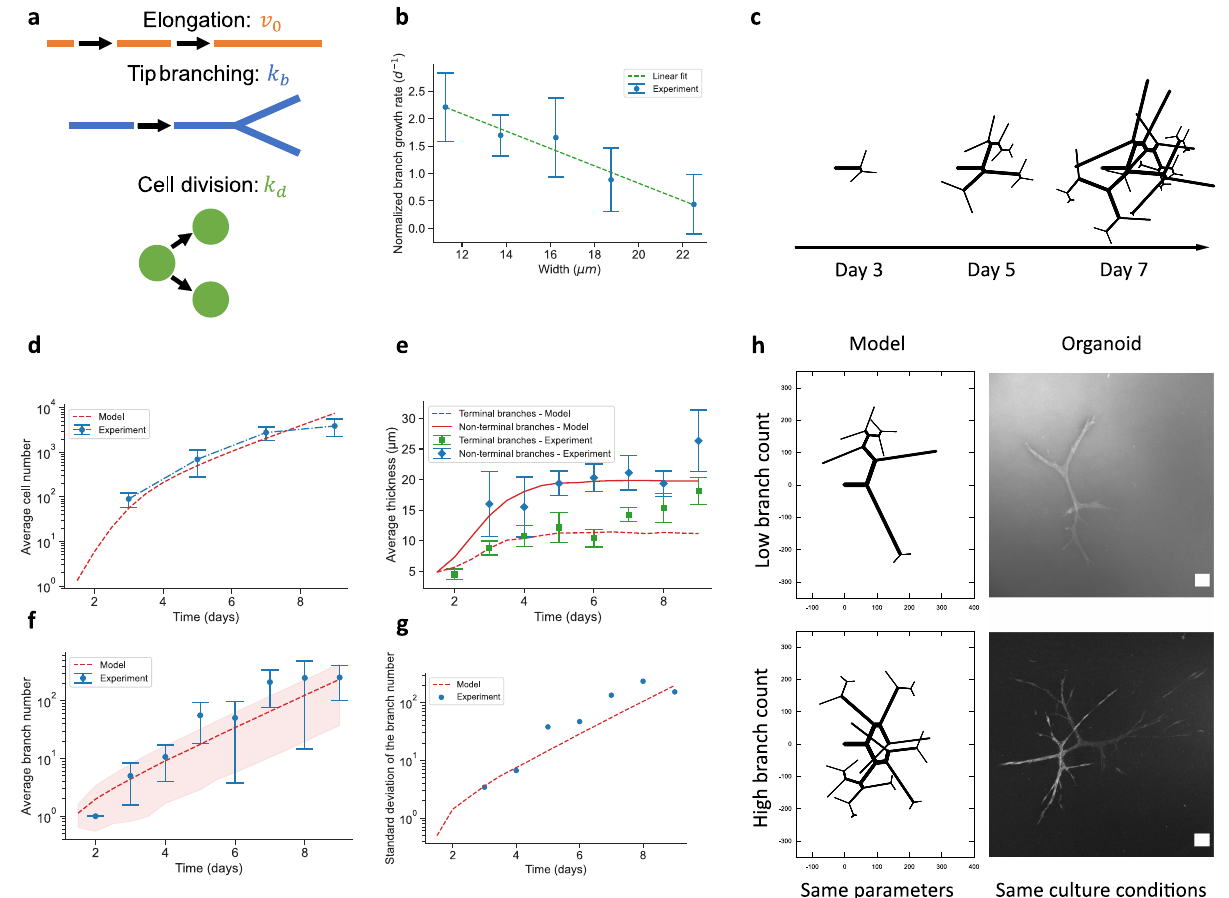
Fig. 4 | A minimal biophysical model captures the main morphogenetic dynamics from the onset phase up to the thickening phase. a Schematic representationoftheprocessesconsideredinthemodel:branchelongationspeed v 0 , branching rate k b , and proliferation rate k d . b Evolution of the normalized volumetric growth rate of branches according to their width for PDAC organoids (blue, n =85points, N =3organoids).Dataisextractedfromliveimagingorganoids between day 7 and 10. We fi nd that a negative linear dependency (green, dashed line) fi tswelltherelationshipbetweengrowthrateandbranchwidth,andallowsus to extract the maximal division rate k d and the maximal branch width at which proliferation is abrogated w 0 . Error bars: mean±standard error of the mean. c Spatial simulation of the branching process over time in pancreatic organoids using the determined PDAC organoids ’ growth parameters. d Evolution of the cell number over time for experimental PDAC organoid data (Experiment, blue solid line, mean±sd, n =55 organoids) and model predictions (red-dashed line).